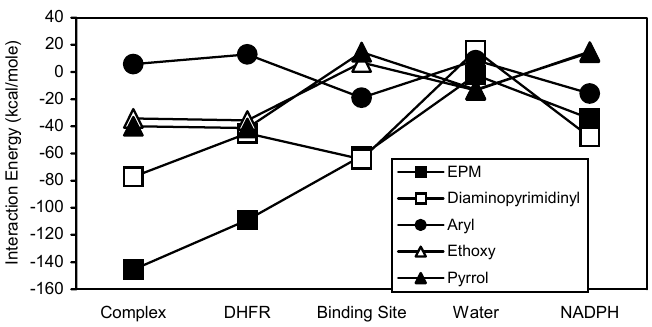
Figure 12. Comparison of interaction energy analysis of EPM and its substructural regions. The EPM interactions with DHFR and binding site are the major contributors to the stability of the EPM interaction with complex. EPM and its diaminopyrimidinyl and aryl substructural regions